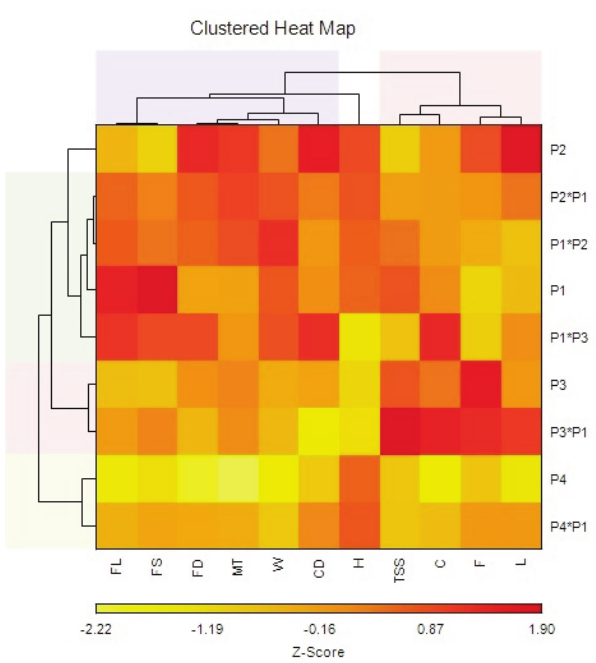
Fig. 2 ­ Ward’s linkage cluster analysis for the studied melon types and their fruit characteristics. P1, P2, P3, and P4 represent the studied lines Cm­UTKH, Cm­UTA, Cm­UTJ, and Cm­UTZ, respectively while two letters genotypes represent F1 direct and reciprocal breeds. FL (Fruit length), FD (Fruit diameter, FS (Fruit shape), MT (Mesocarp thickness), CD (Cavity diameter), W (weight), F (Firmness), TSS (Total soluble solids), L* (Lightness), H (Hue), C (Chroma). The colors of the heat map represent the normalized values of raw data to Z score. Thus, red colors or yellow colors represent values higher or lower than the average value for each studied characteristic,